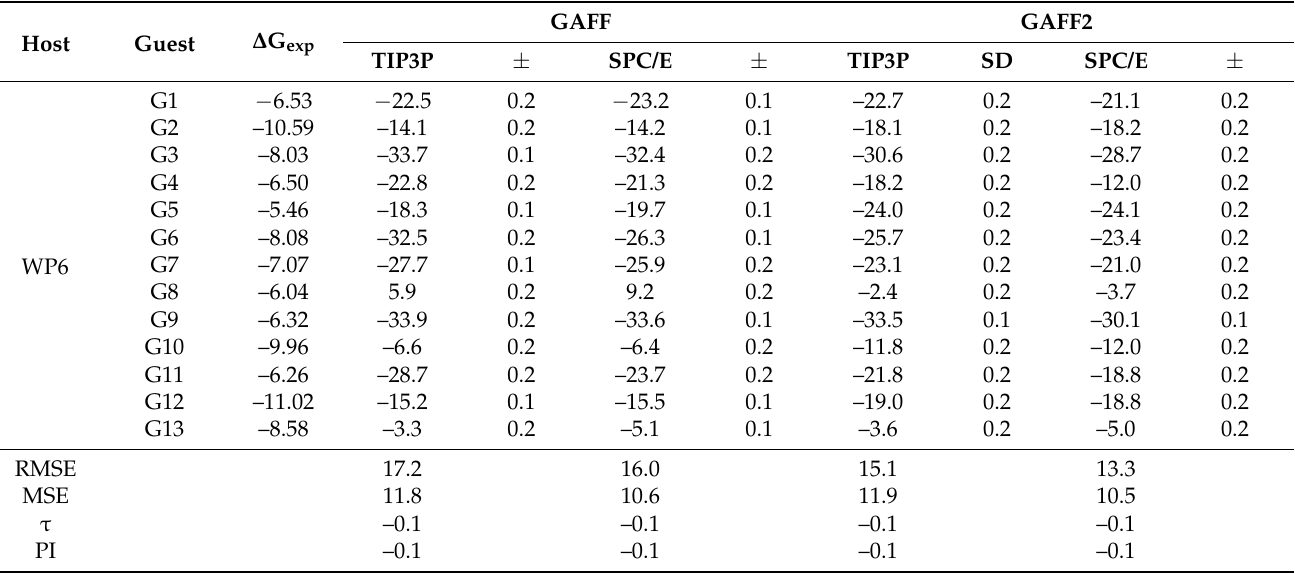
Table 1. Single-trajectory MM/PBSA estimates under GAFF and GAFF2. MSE, RMSE, τ , and PI serve as quality measurements.